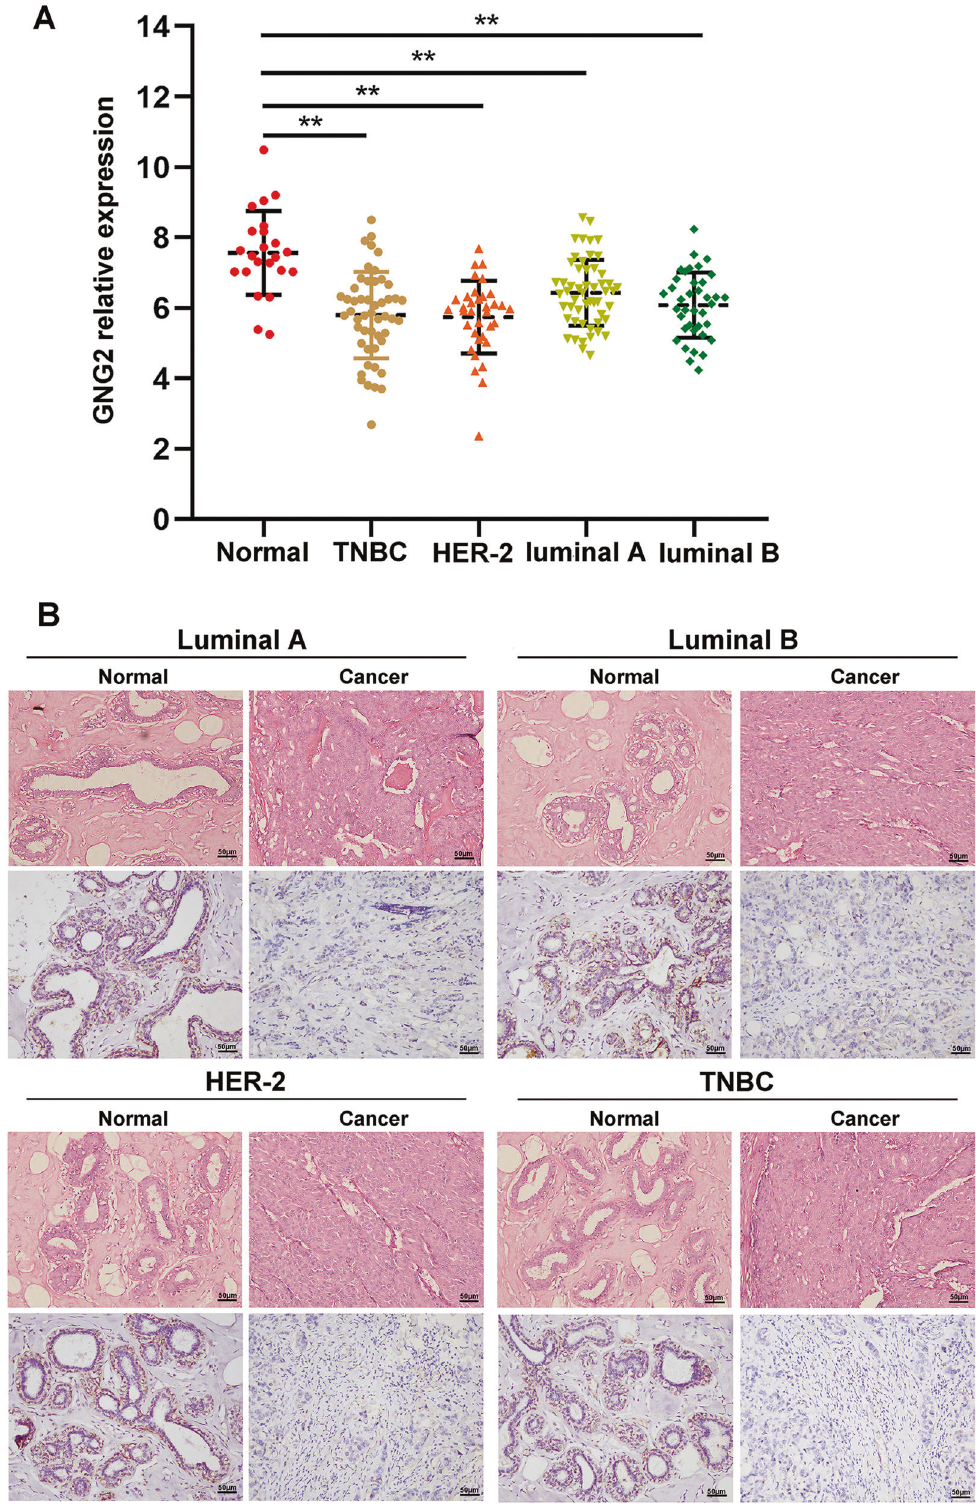
Fig. 3 GNG2 expression in BC subtypes. A GNG2 mRNA expression in four BC subtypes. B Immunohistochemical staining of GNG2 in tumor and non-tumor tissues from patients with luminal A ( n = 23), luminal B ( n = 15), HER-2 ( n = 13), and TNBC ( n = 12). Data are expressed as the mean ± SD. ** p <